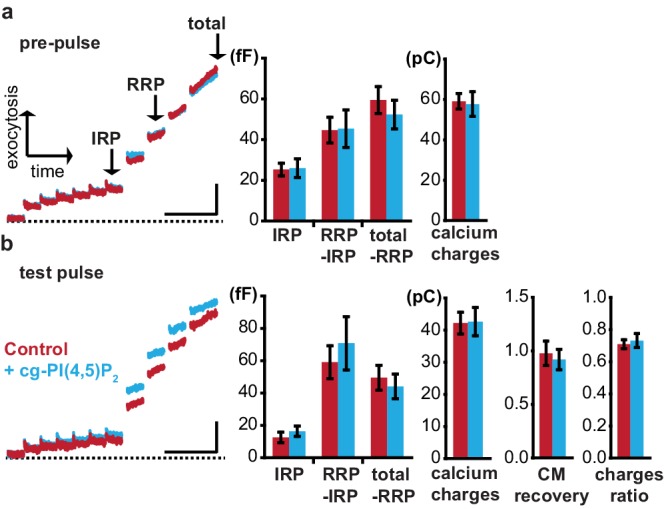
Incubation with cg-PI(4,5)P2 does not affect exocytosis.Chromaffin cells were incubated with either 0.02% pluronic (Control) or 0.02% pluronic +25 µM cg-PI(4,5)P2 (+cg-PI(4,5)P2) for 30 min as described earlier. Reliable uptake of cg- PI(4,5)P2 was verified by the coumarin fluorescence at the end of the recording session (only for the +cg-PI(4,5)P2 group). (a) Average capacitance traces of exocytosis (left panel) elicited during the pre-pulse (a) and test pulse (b) stimulations of cells incubated with pluronic (Control) (dark red) or pluronic +cg-PI(4,5)P2 (light blue) and quantification (mean ±S.E.M) (right panel). The cells were not subjected to UV-light between the pre-pulse and test pulse. The release was identical from both groups during the pre-pulse and test pulse stimulation. Secretion from both groups recovered to comparable magnitudes during the test pulse as estimated by the CM (membrane capacitance) recovery (test pulse ΔCM_4 s/pre-pulse ΔCM_4 s) indicating that release was not influenced by the loading of cg-PI(4,5)P2. The calcium charges were calculated by integrating the currents during the depolarization pulses. Charges ratio were calculated by dividing the sum of charges in test pulse by the sum of charges in the pre-pulse. All the parameters were statistically tested using Student’s two-tailed t-test: pre-pulse: (IRP) p=0.9060, (RRP-IRP) p=0.9469, (total-RRP) p=0.4634, (calcium charges) p=0.8425; test pulse: (IRP) p=0.4078, (RRP-IRP) p=0.5360, (total-RRP) p=0.6249, (calcium charges) p=0.9344, (CM recovery) p=0.7082, (charges ratio) p=0.6618. Scale bars 25 fF/1 s. Number of cells (n) in electrophysiological recordings: n = 24 (Control), n = 21 (+cg-PI(4,5)P2).